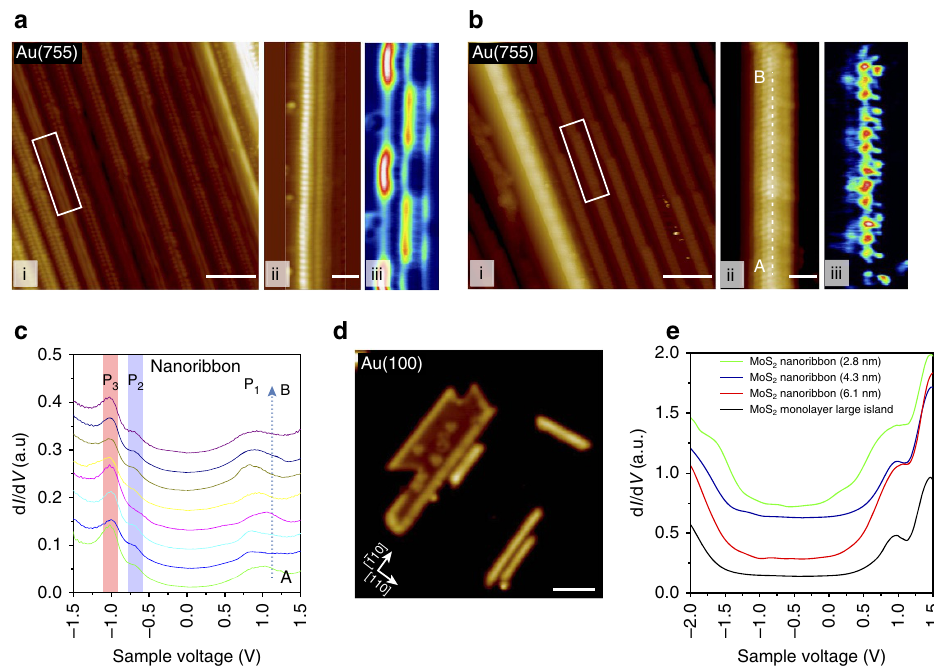
Figure 4 | Electronic structure characterization of twin nanowires and MoS 2 nanoribbons. ( a , i) Large-scale STM image of twin nanowire arrays grown on the Au (755) surface and (ii) the close up STM image as well as (iii) the corresponding d I /d V map obtained at V b ¼ (cid:3) 0.6V in the right panel. ( b , i) Large-area STM image of the MoS 2 nanoribbons array and (ii) the close up STM image as well as (iii) the corresponding d I /d V map obtained at V b ¼ (cid:3) 0.6V in the right panel. ( c ) A set of spatially resolved d I /d V spectra taken along the long axis of MoS 2 nanoribbons as marked from position A to position B in the STM image ( b , d ), MoS 2 nanoribbons with different sizes synthesized on Au (100) surface. ( e ) d I /d V spectra acquired at the center of a series of MoS 2 nanoribbons show the size-dependent bandgap. Scale bars, 5nm ( a , b ), 1nm for close up images and 10nm ( d )